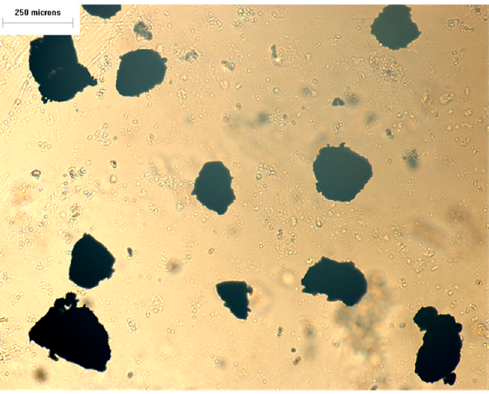
Figure 16. Optical micrographs of the original EPDM powder.